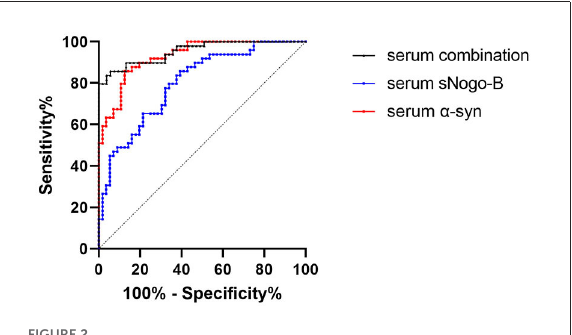
FIGURE2 ROC curve of serum levels of sNogo-B (AUC = 0.801, p < 0.0001), serum α -Syn (AUC = 0.93, p < 0.0001) and combination of them (AUC = 0.9534, p < 0.0001). Both sNogo-B and α -Syn in serum presented significant diagnostic value of PD; Combination of sNogo-B and α -Syn presented the higher diagnostic value of PD.